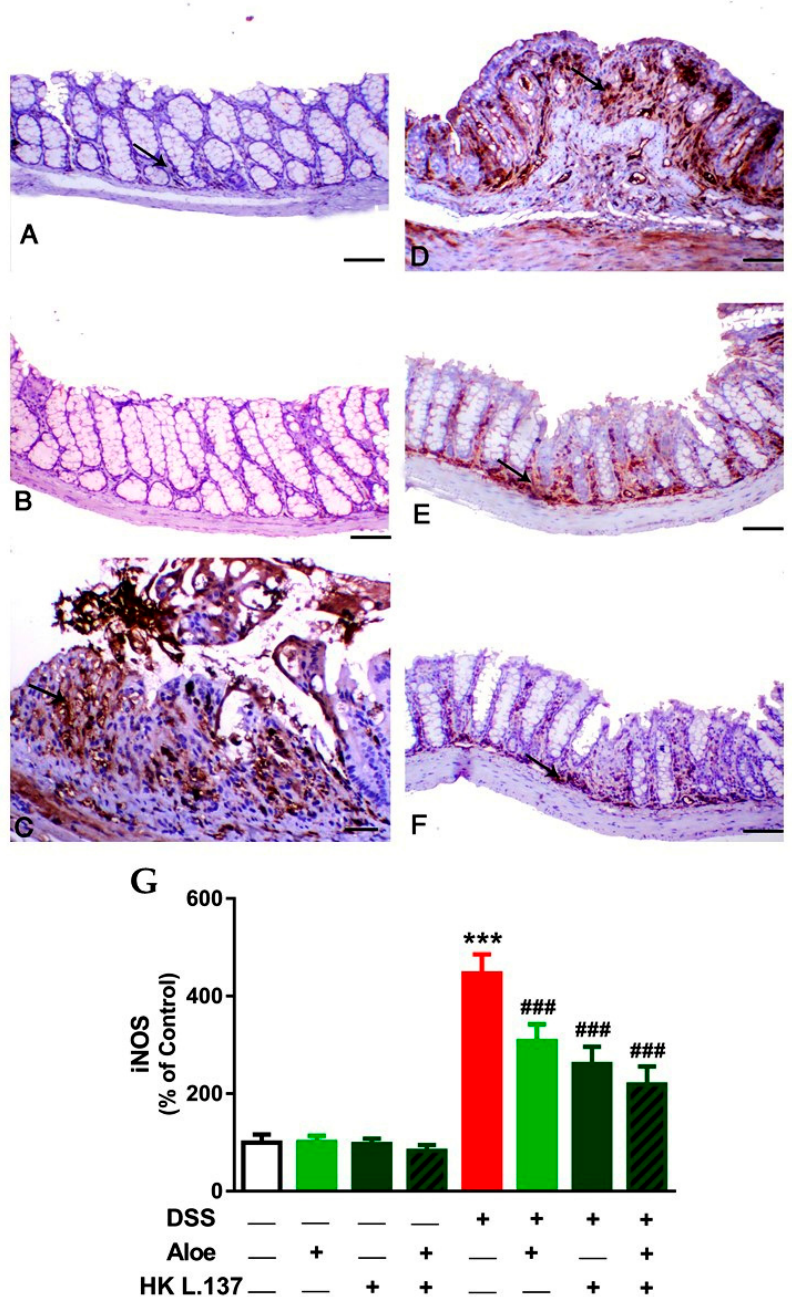
Figure 5. Aloe and / or HK L.137 suppress iNOS expression in the colon of DSS-challenged mice. iNOS immunostained colon sections from ( A ) Control and ( B ) Aloe / HK L.137-treated mice showing mild expression, ( C ) DSS-induced mice showing marked expression, and ( D – F ) DSS-induced mice treated with Aloe ( D ), HK L.137 ( E ), and their combination ( F ) showed decreased expression. Arrows indicate positive immunostaining which expressed mostly from the inflammatory cells. ( G ) Mean ± SD of the NF- κ B p65 expression in colon of di ff erent groups. *** p < 0.001 versus Control and ### p < 0.001 versus DSS. (Scale bar = 50 µ